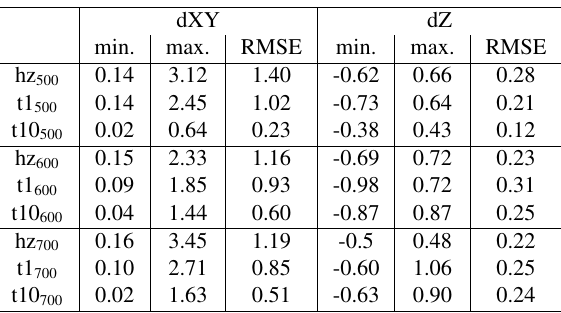
Table 1. Planimetric and depth coordinate displacements (in percent of the water depth) for different flying heights (500m, 600m, 700m) with respect to horizontal water surface (hz),